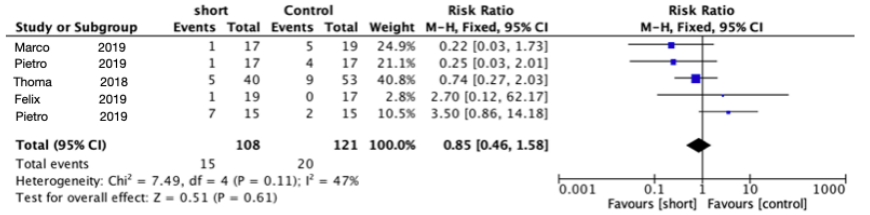
Figure 3. Comparison of biological complications using short implants vs. longer implants with elevation of the sinus floor after 5 years in function via a meta-analysis.